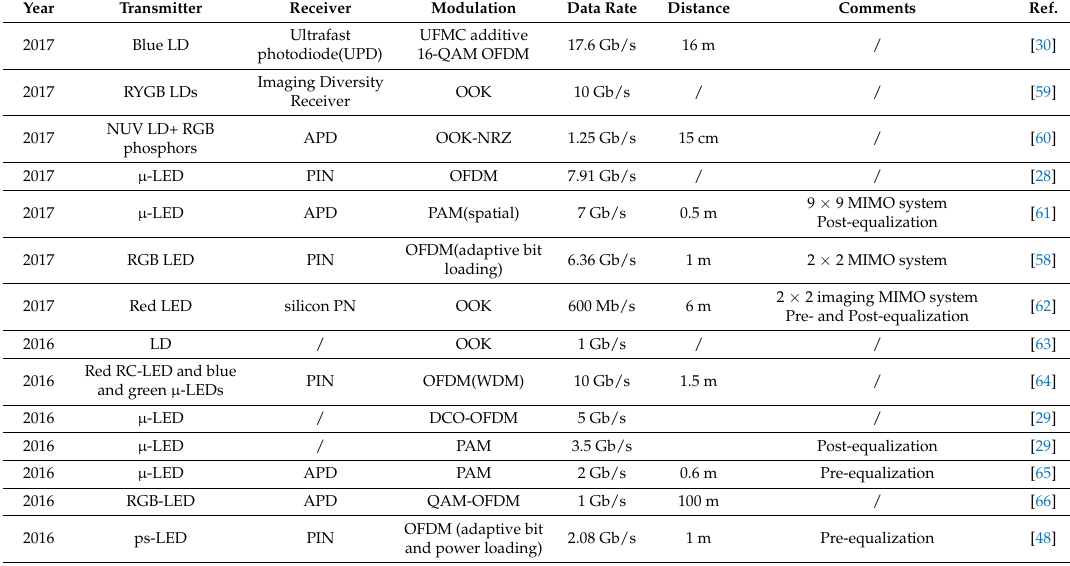
Table 1. Survey of practical demonstrations of high-speed VLC